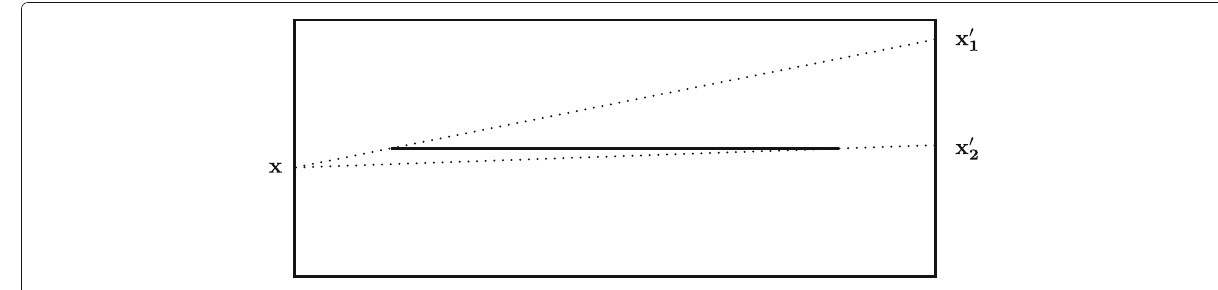
3. Due to the singularity of the kernel k ( x , x (cid:9) ) , when two nodes on the neighboring wall are sufficiently close, the variation of k ( x , x (cid:9) ) on a single element is significant for whatever small step size has been chosen. To overcome this singularity, the following approximation is applied to these nodes.